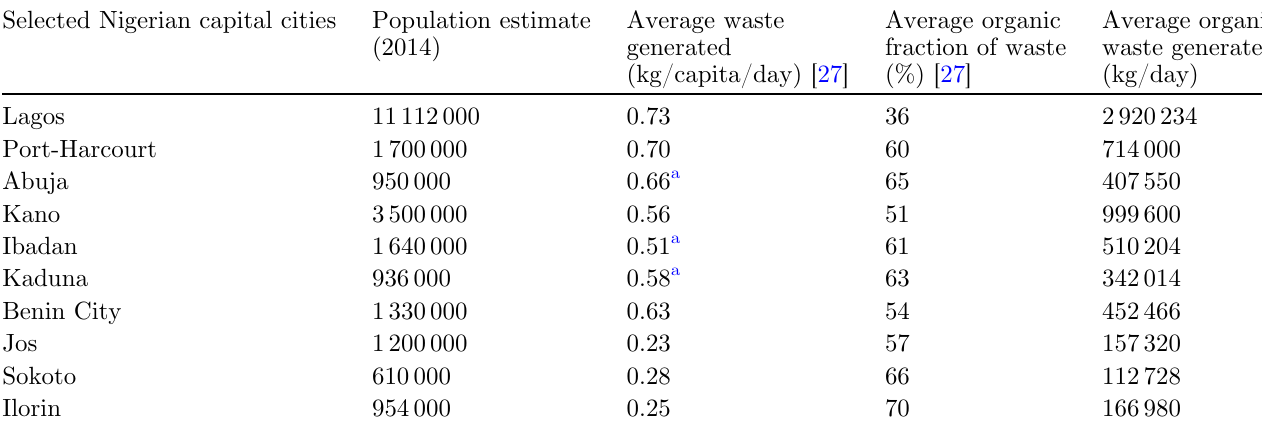
Table 1. Average organic waste generated in ten selected cities of Nigeria. Selected Nigerian capital cities